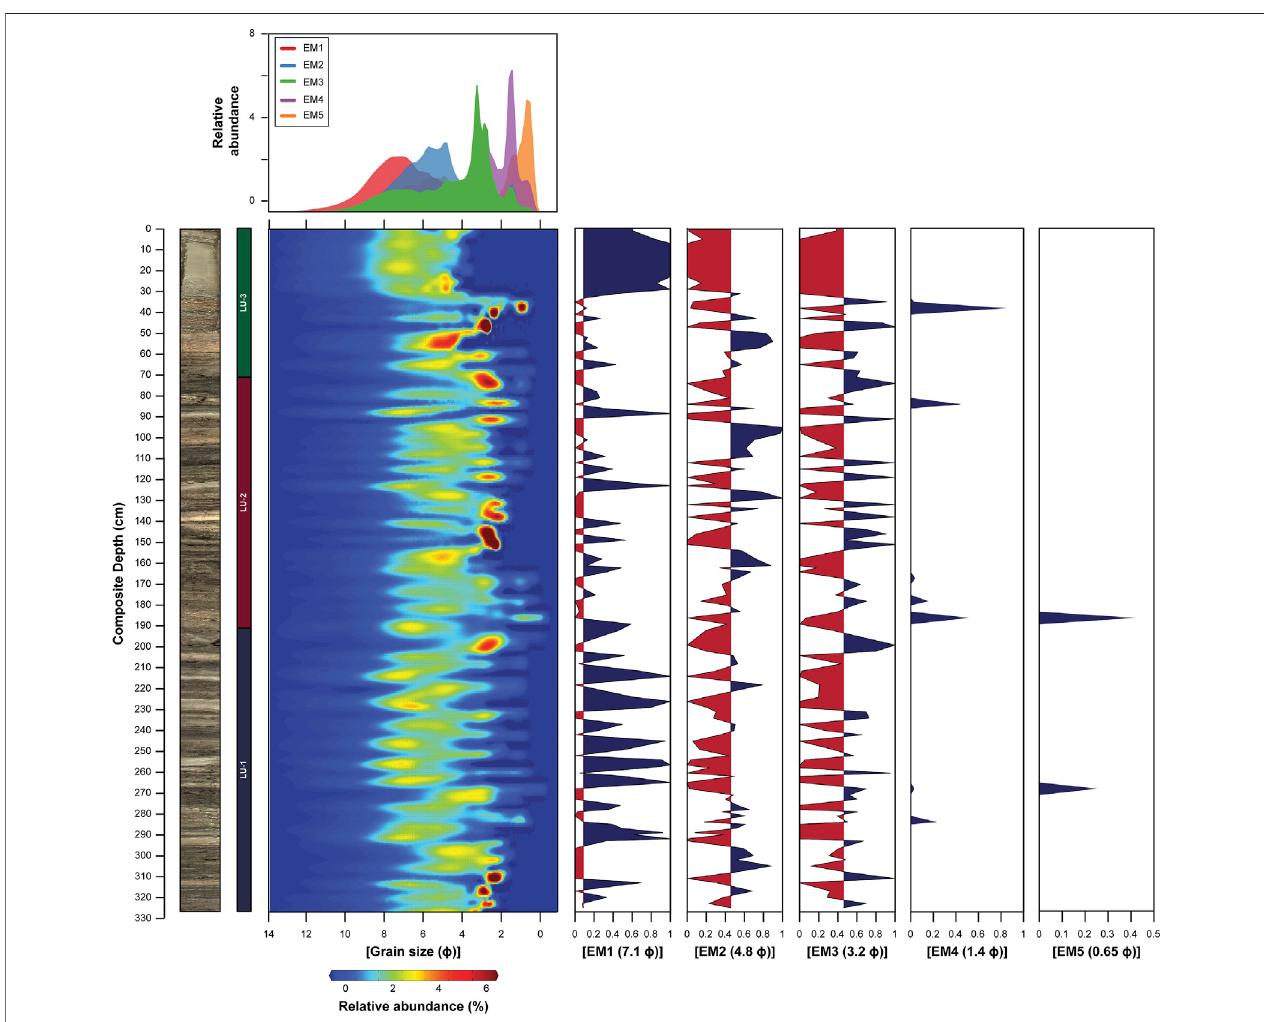
FIGURE 6 | Overlay of the grain size distribution of all samples and particle distribution through down-core sediments and fi ve end members with their relative abundance plotted against the composite depth.